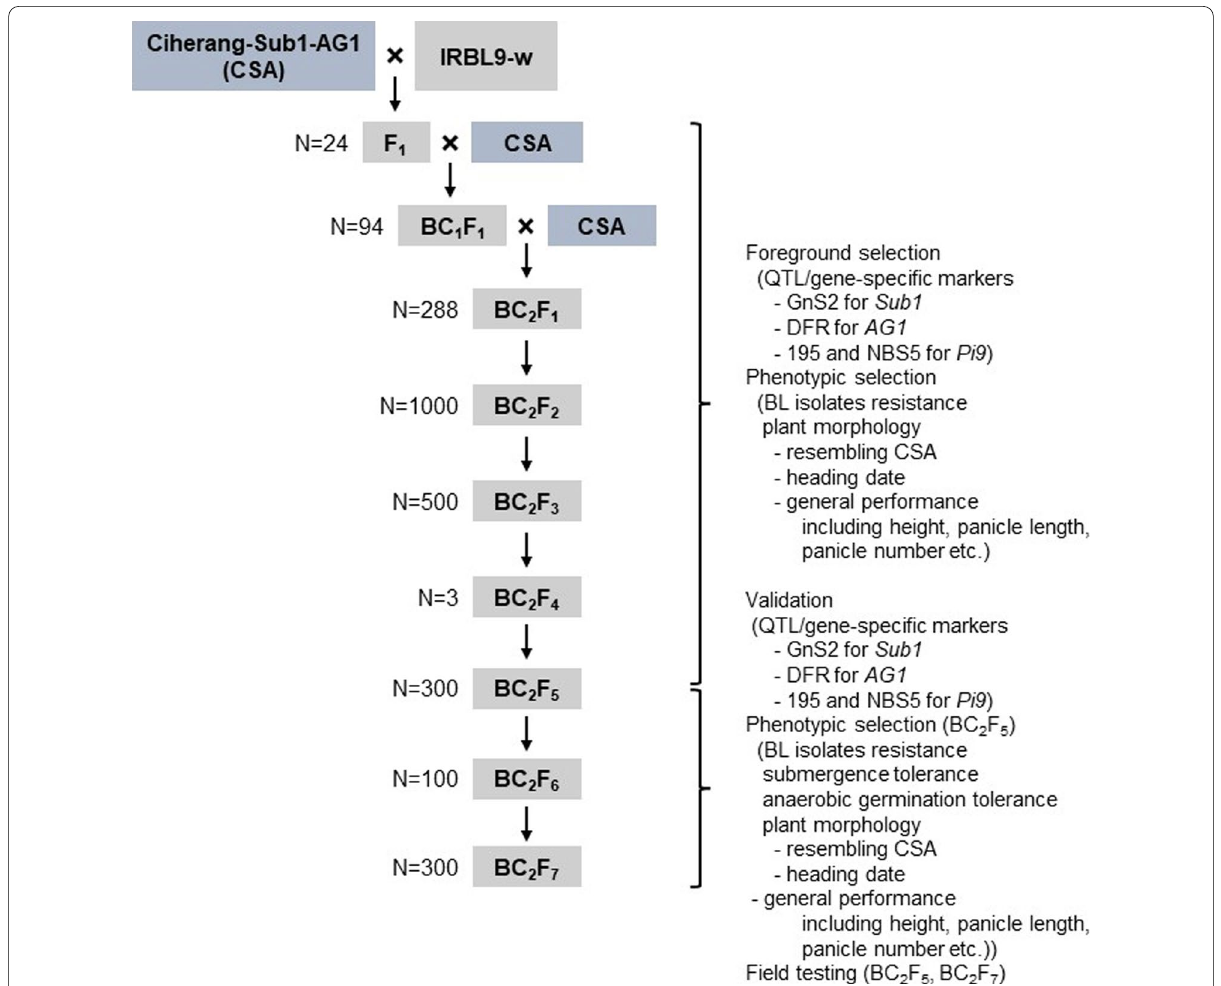
Fig. 1 Schematic representation of the breeding strategy used to develop CSA‑Pi9 via marker‑assisted backcrossing (MABC). CSA: recurrent parent; IRBL9‑w: donor parent; BL isolates: blast